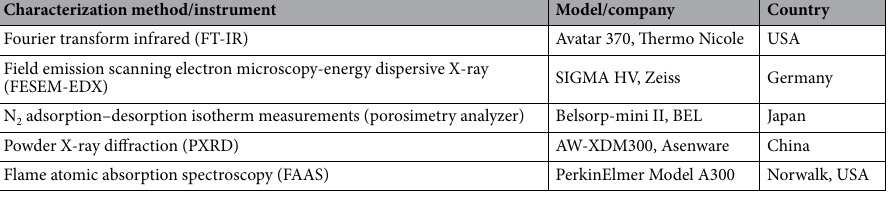
Table 6. Instruments and